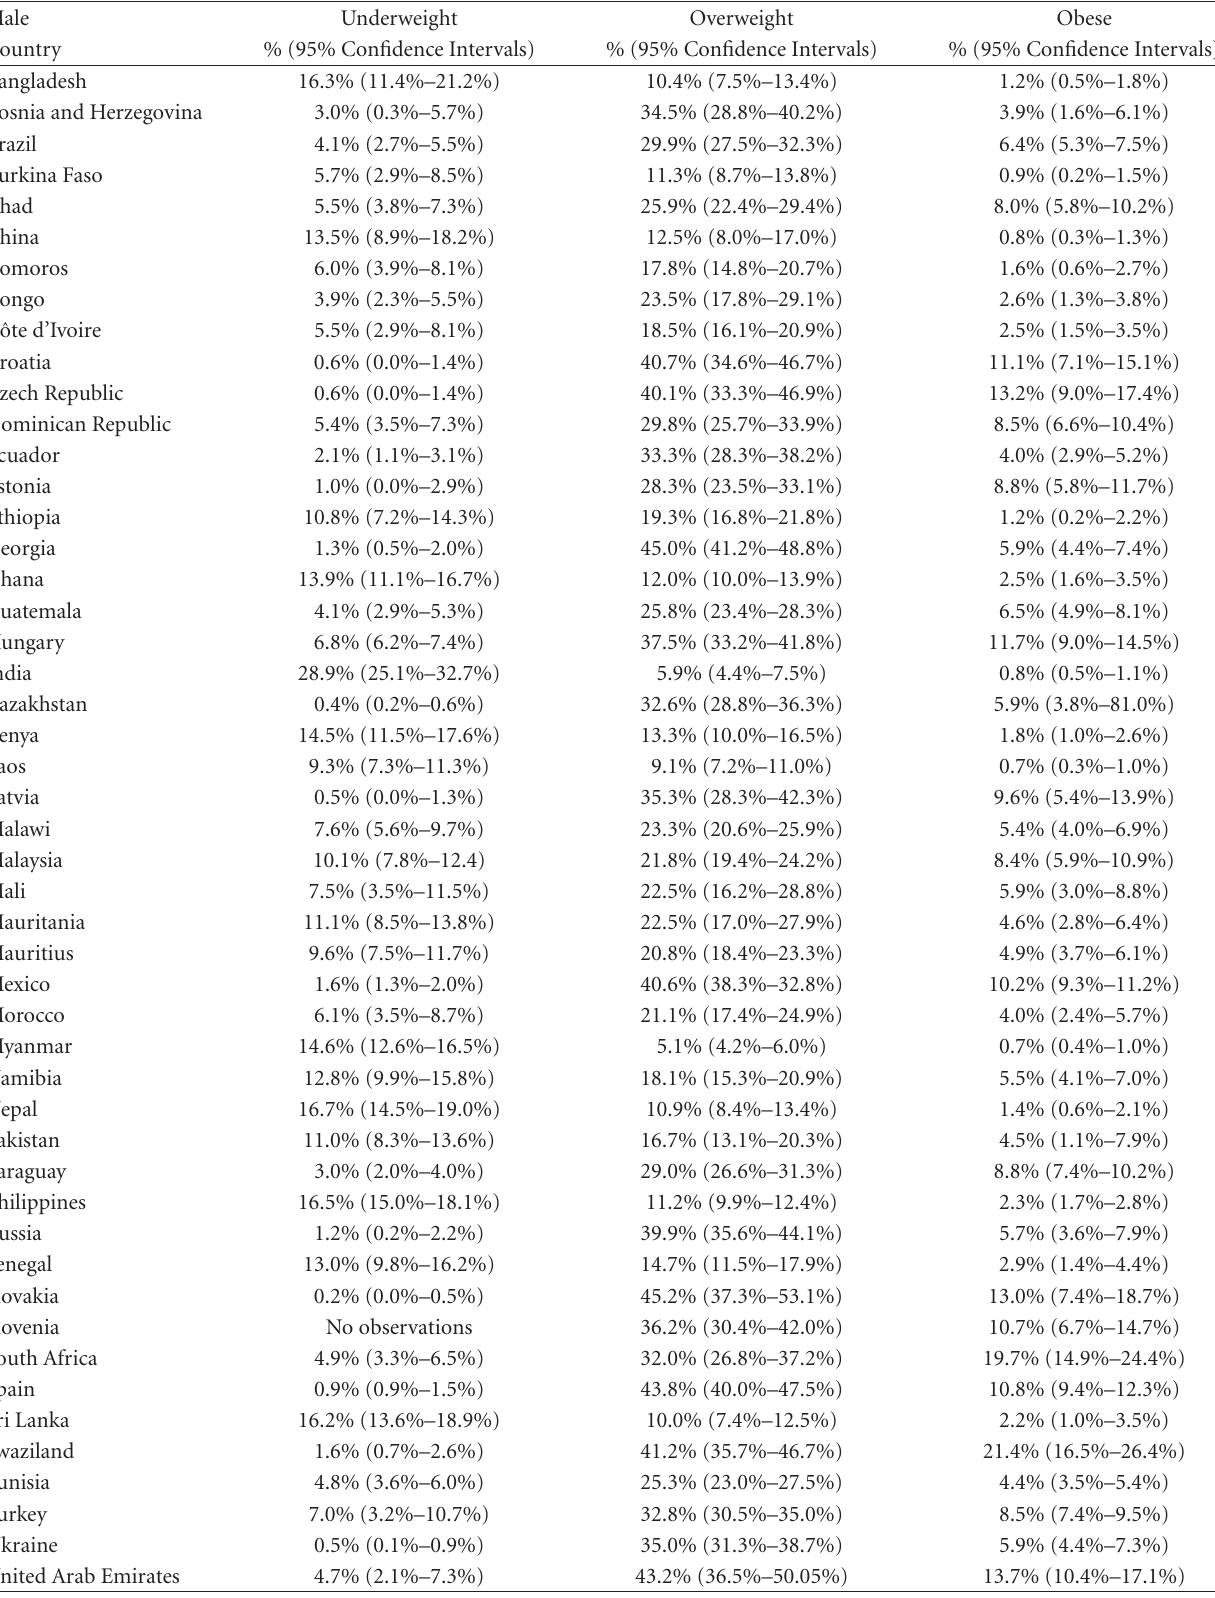
Table 2: Prevalence of body mass index (BMI) classification, by sex (male) and country, WHS,